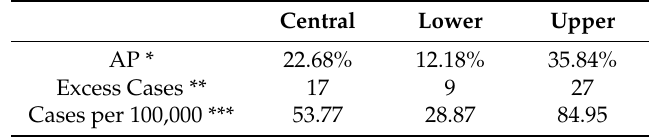
Table 6. Postneonatal infant mortality with the associated parameters.